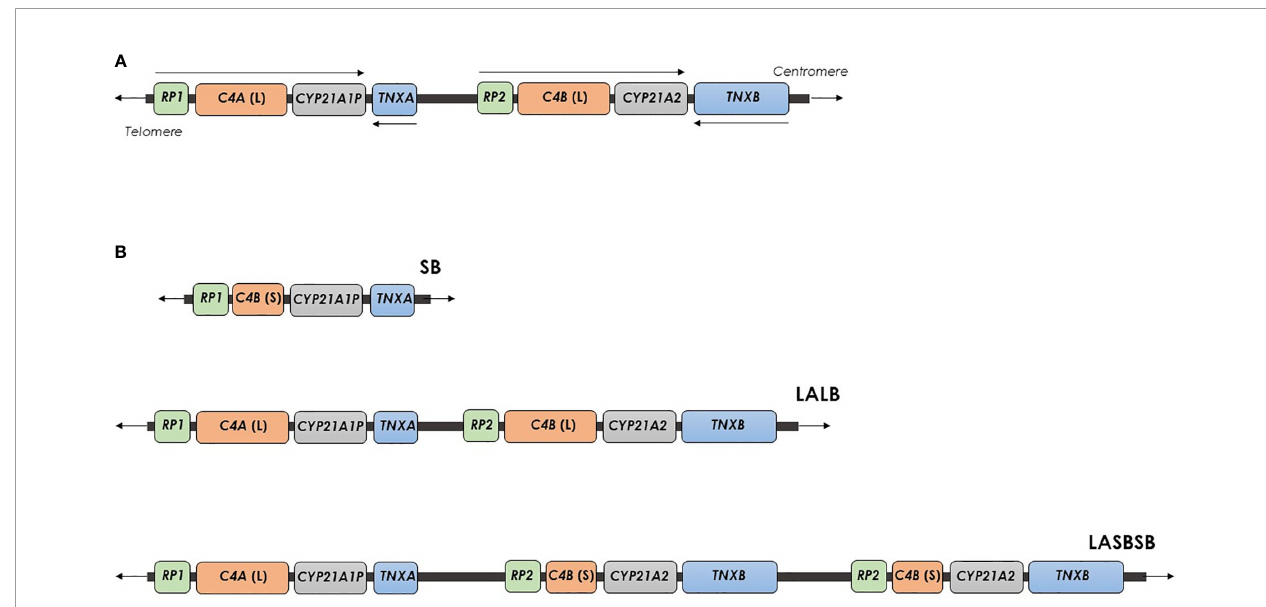
FIGURE 1 | Organization of the human RCCX CNV on chromosome 6. (A) RCCX structure with two segments containing the genes STK19-C4A-CYP21A1P-TNXA- STK19B-C4B-CYP21A2-TNXB , with a telomere-to-centromere orientation. Arrows indicates the transcriptional orientation of genes. (B) RCCX structures with one, two and three segments. Each segment is indicated with two letters, the fi rst represents the allele of the HERV-K ( C4 ) CNV [L, Long allele (insertion) or S, Short allele (deletion)], and the second indicates the types of C4 gene (A or B). SB, A RCCX structure with one segment including a C4B gene without HERV-K ( C4 ) insertion. LALB, A RCCX structure with two segments including two C4 genes, A and B, both with HERV-K ( C4 ) insertion. LA SB SB: A RCCX structure with three segments including a C4A gene with HERV -K( C4 ) insertion and two C4B genes without HERV-K(C4 )